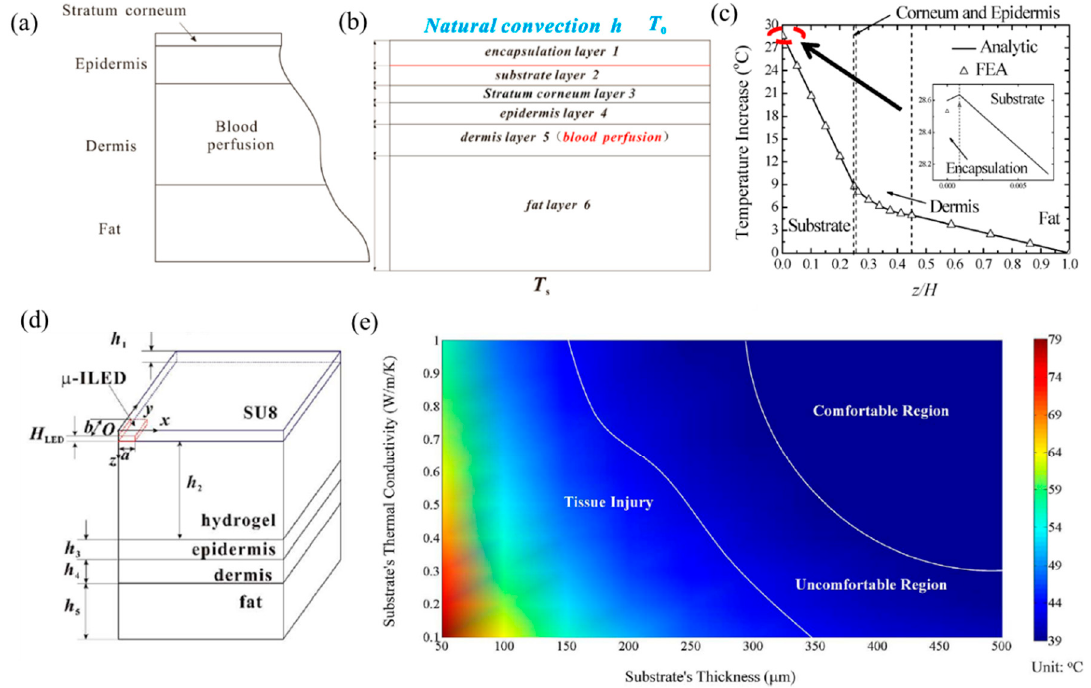
Figure 5. Schematic illustration of ( a ) the skin tissue structure and ( b ) the geometry of the analytical modeled system [70]. ( c ) The comparison of temperature increase along the thickness direction between the analytical prediction and FEA [70]. ( d ) The three-dimensional analytical model showing a quarter geometry of the μ -ILED device integrated with skin tissue [71]. ( e ) The dependence of the thermal comfort map on the thickness and thermal conductivity of the substrate [71].